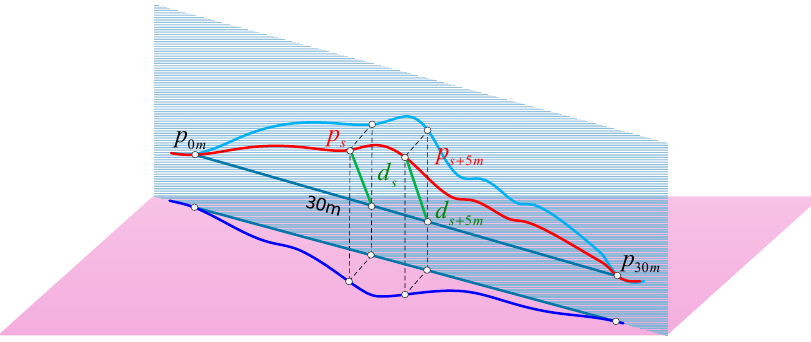
Figure 2. Vector distances of two points with 5 m interval on a 3D curve for 30 m chord.